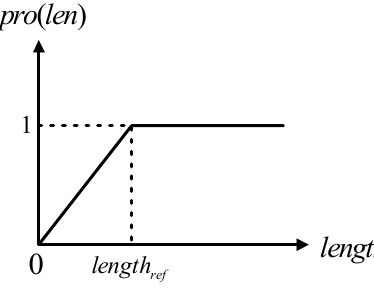
Figure 4. Distribution of extension index.